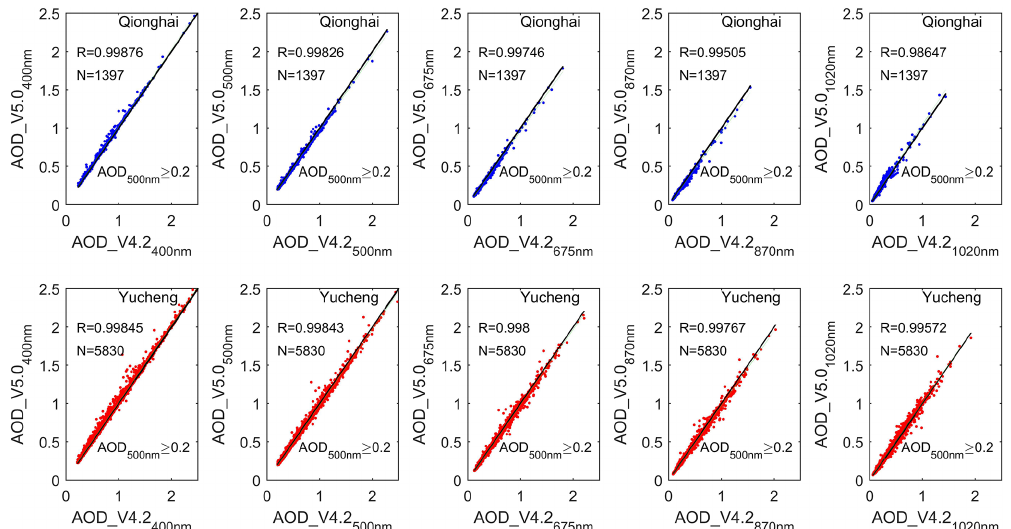
Figure 2. Scattergrams of the AOD derived by SKYRAD V4.2 and V5.0 at wavelengths of 400, 500, 670, 870, and 1020nm over Qionghai and Yucheng during February 2013 to December